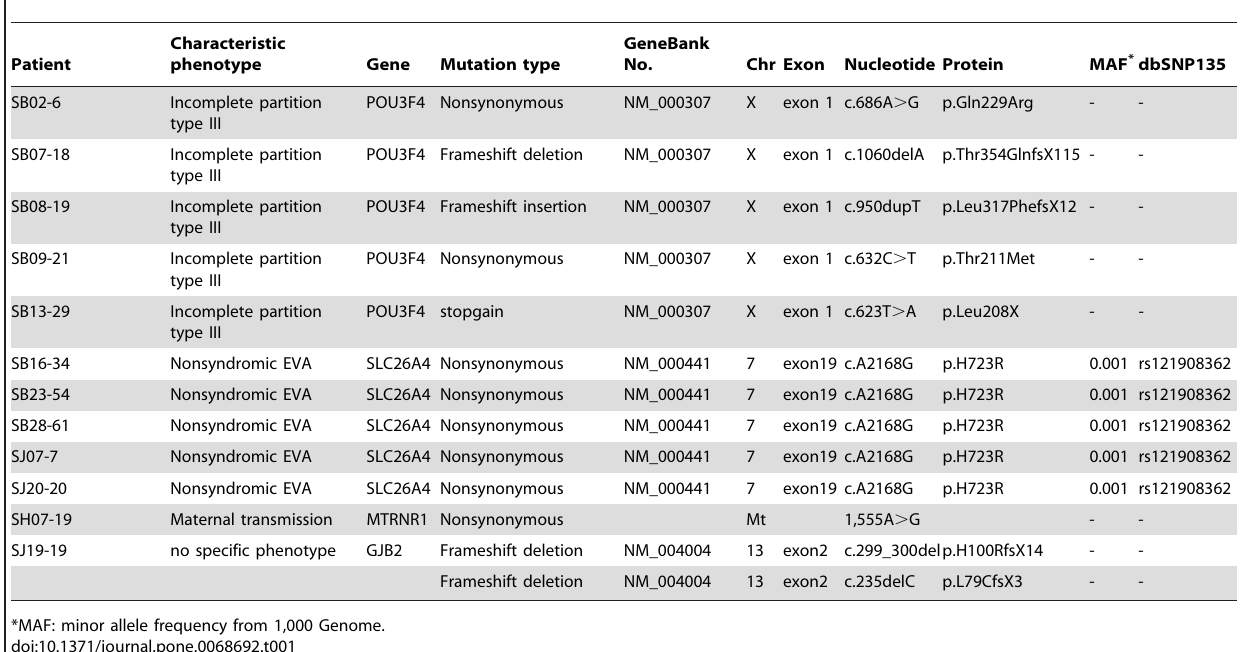
Table 1. Mutations of SLC26A4, POU3F4, GJB2 and MTRNR1 in 12 familial NSHL found by PCR-Sanger sequencing.